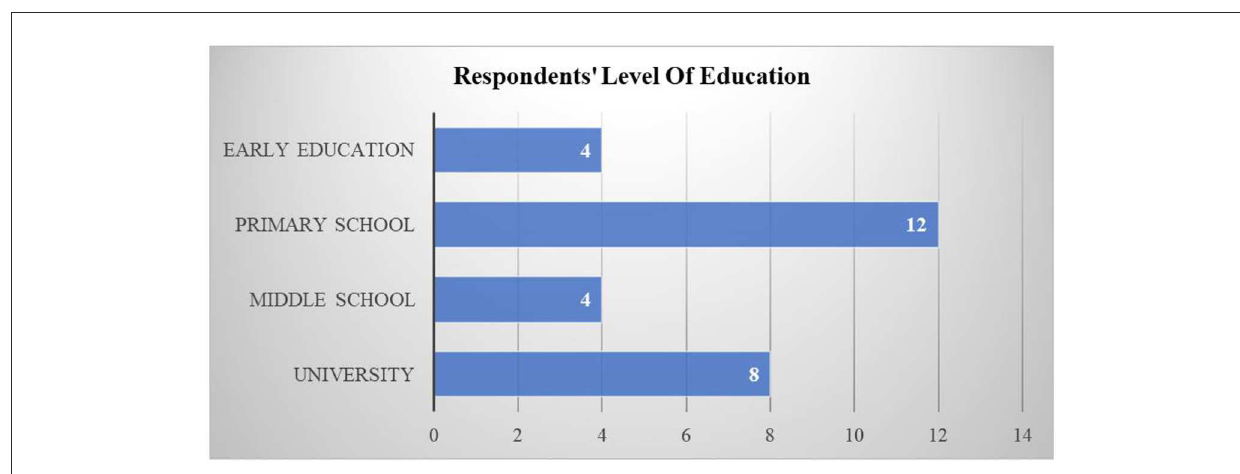
FIGURE5 The number of articles based on the respondent’s level of